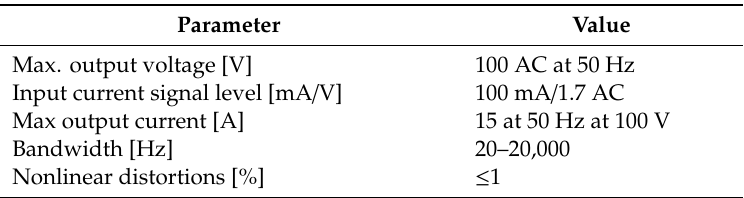
Table 2. Amplifier basic parameters.